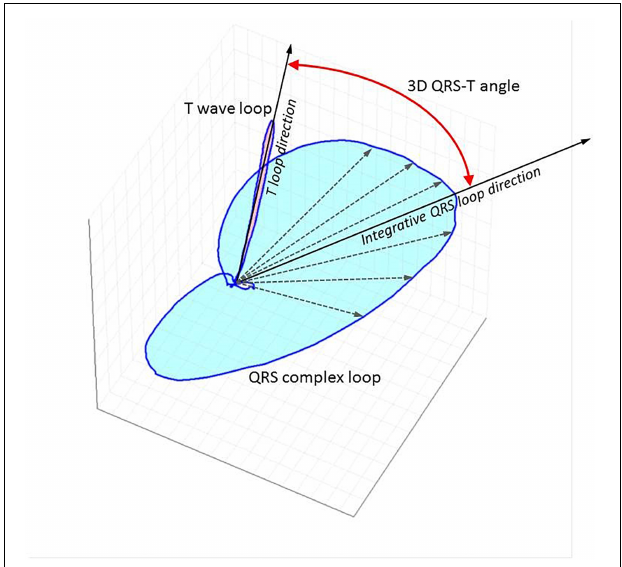
FIGURE 1 | Three-dimensional representation of QRS and T vector loops following computerized analysis of standard 12 lead ECG using singular value decomposition to yield an orthogonal lead system (TCRT method). The little white circle in the middle depicts the loop of the p wave. The curved red line with arrow at both ends depicts the spatial QRS-T angle. The maximal T wave vector magnitude is used for the calculations with this method. TCRT is the averaged cosine of the angles between the T wave vector and all vectors within the QRS complex exceeding a pre-defined level. A different method of QRS-T angle measurement from standard 12 lead digital snapshot ECG uses inverse Dower matrix for vectrographic transformation and calculates the angle between the mean vectors of the QRS and T wave. QRS-T angle has also been calculated from continuous signal averaged ECGs as the angle between the peak QRS vector and the peak T